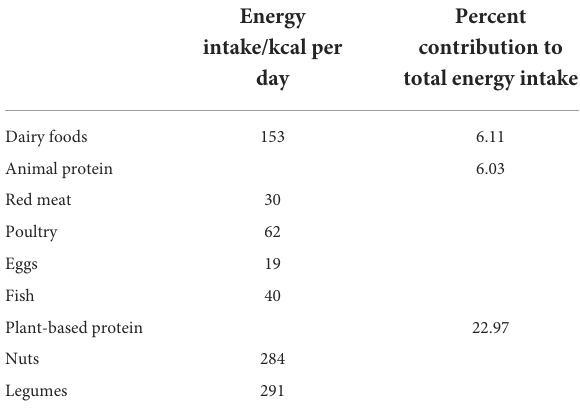
TABLE 1 EAT-Lancet reference diet in energy and percentage contribution to total energy intake for protein source food